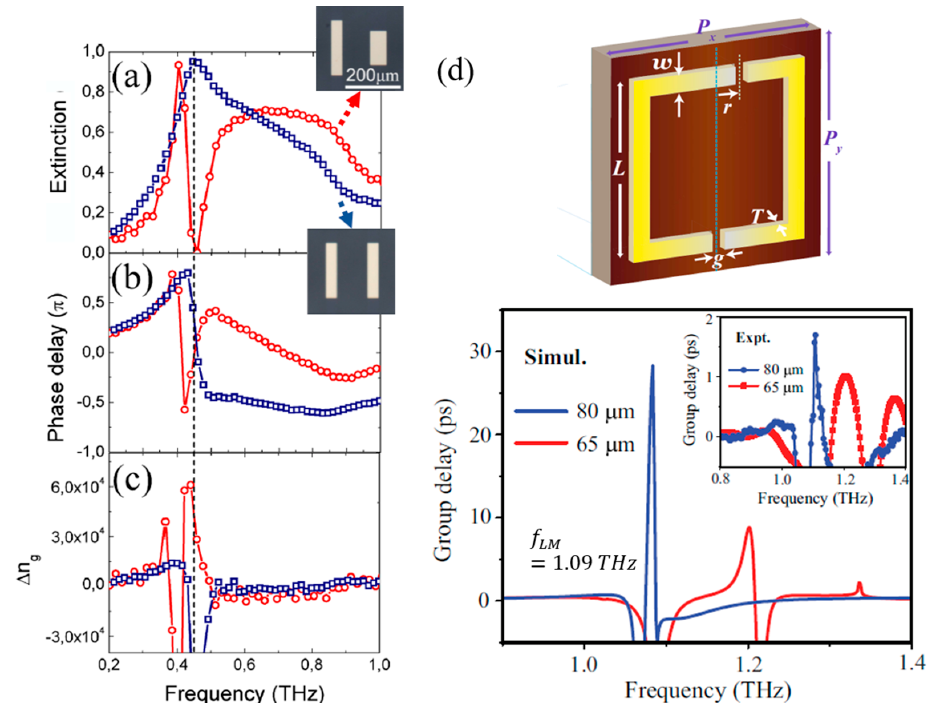
Figure 11. Slow light. ( a ) Extinction, ( b ) phase delay and ( c ) group index spectra of arrays of pairs of identical “symmetric” (blue) and distinguishable “asymmetric” (red) gold nanorods. The vertical dotted line at 0.45 THz indicates the frequency of the induced transparency in the asymmetric array. Adapted with permission from ref [41], American Chemical Society. ( d ) Numerically obtained (main graph) and experimental (inset) group delays for asymmetric split ring metamaterials with lattice constants 𝑃 = 65 and 80 μm . Adapted with permission from ref [35], American Physical Society.